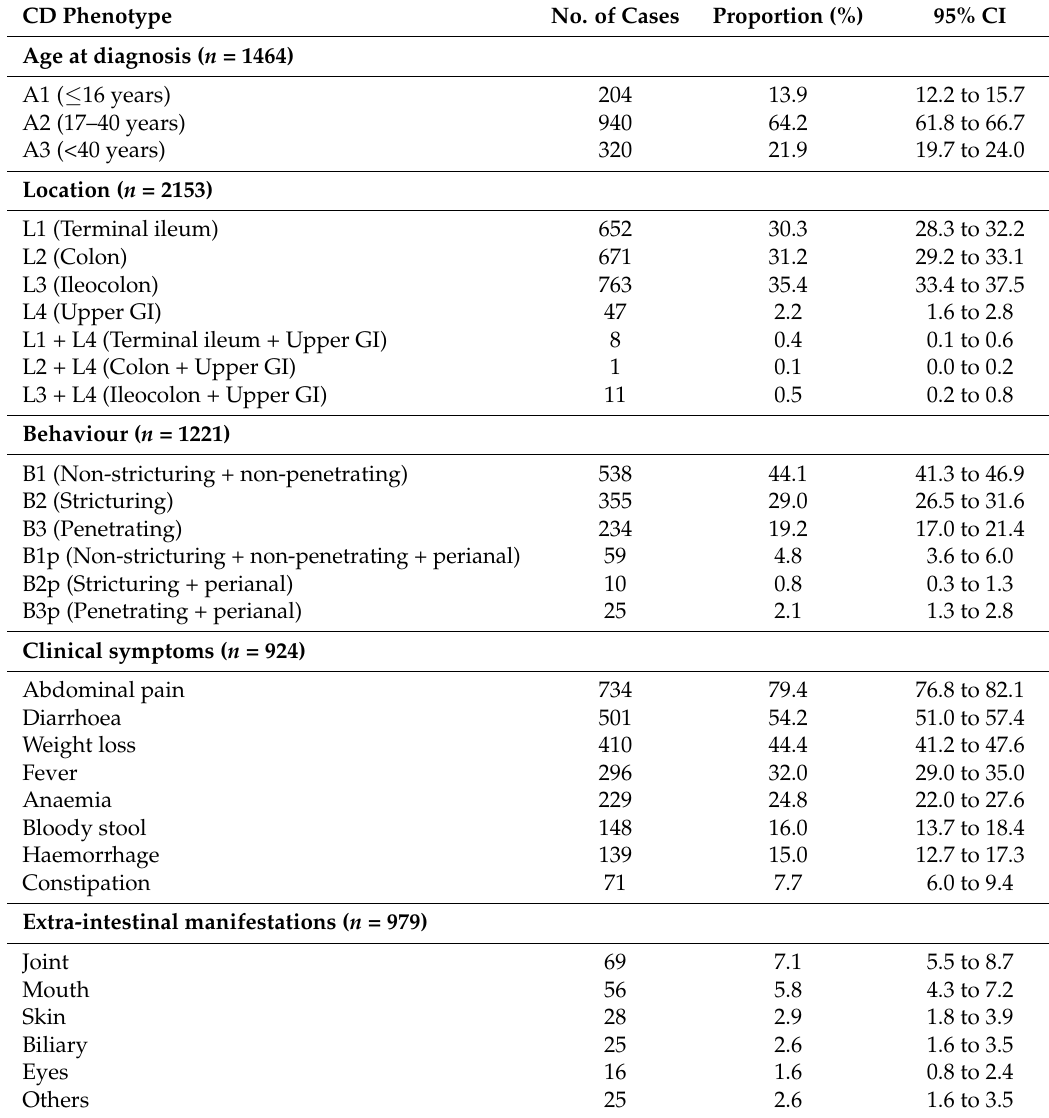
Table 1. The phenotypic and clinical characteristics of Crohn’s